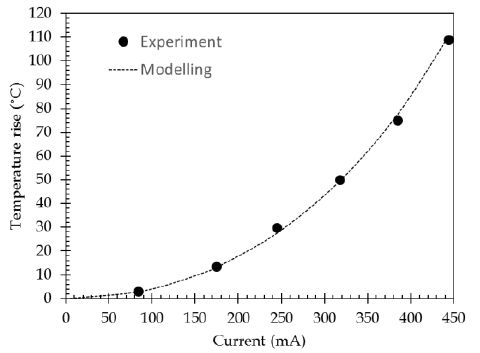
Figure 14. Comparison between the modeled and experimental temperature rise values at the channel center versus the injected current.